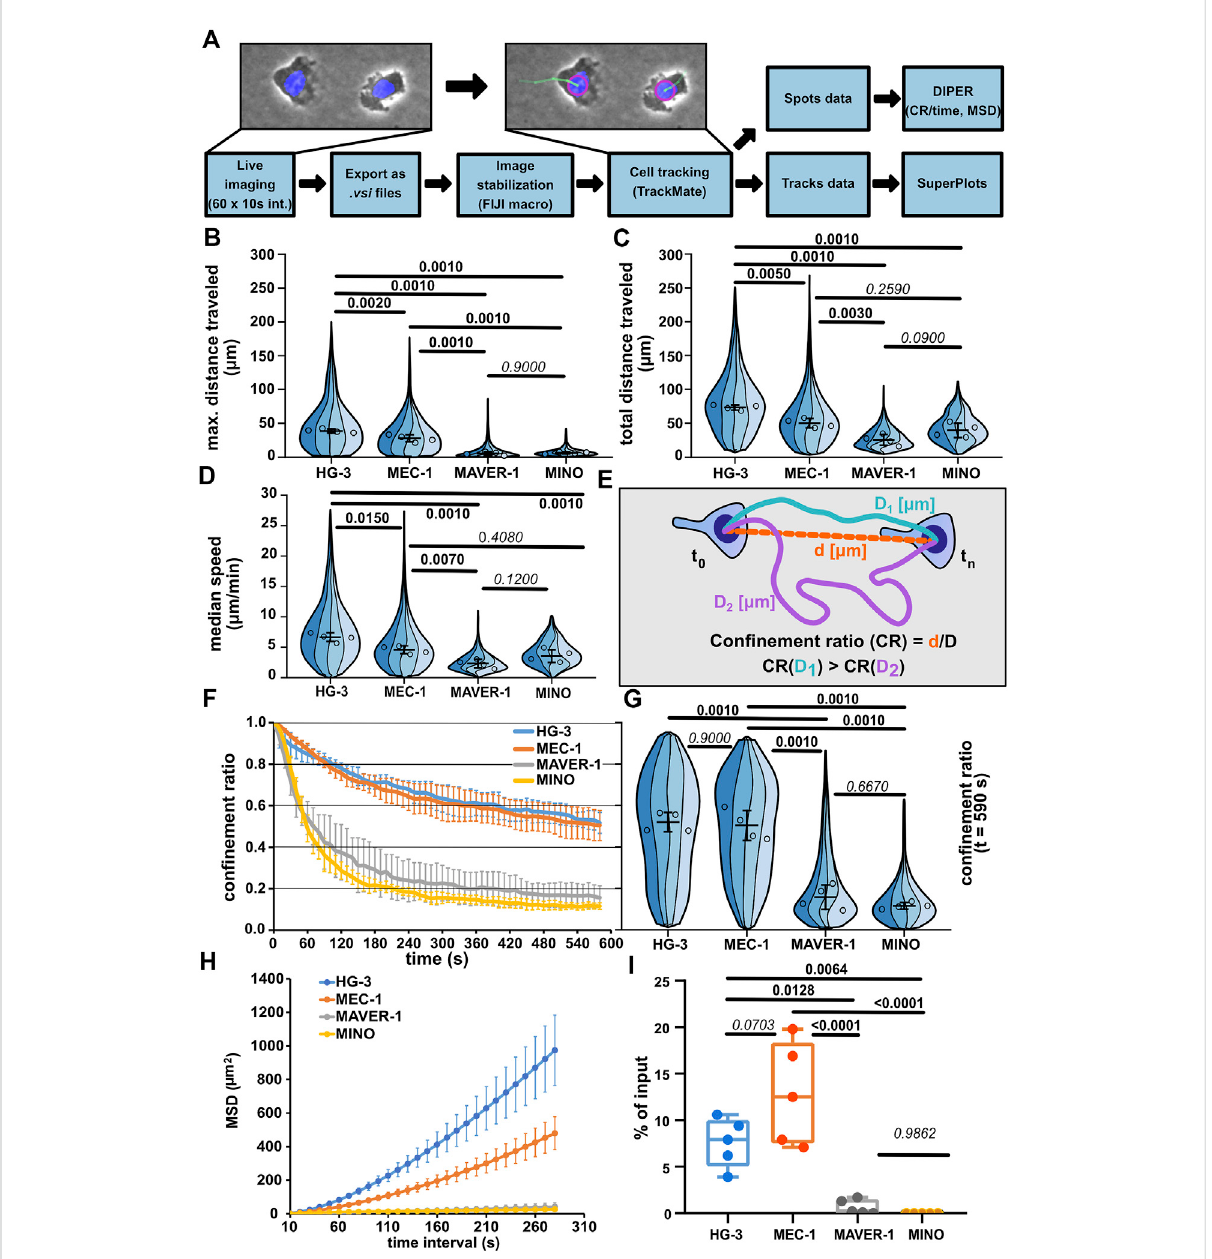
FIGURE 2 Comparison of migratory properties of leukemic cell lines. (A) Scheme of the data processing pipeline used for the quanti fi cation of migration parameters. FIJI macro used for pre-processing images for tracking can be found inSupplementary Materials. (B) Maximum distance traveled by the tested cell lines. SuperPlot sections of different colors represent distributions of individual replicates. Circles represent the median values of replicates,whichwereusedforstatisticalanalysis(one-wayANOVA, n =4, p < 0.001,andtheposthocTukeytest)( p valuesshowninthegraph). Errorbar:meanandSD. (C) Totaldistancetraveledbythetestedcelllines.SuperPlotssetasinFigure2B.Statistics:one-wayANOVA, n =4, p < 0.001, and the post hoc Tukey test. (D) Median speed of the tested cell lines. Superplot setting as in Figure 2B, statistics: one-way ANOVA, n = 4, p < 0.001, andtheposthocTukeytest. (E) Schematicdepictionofthecalculationofthecon fi nementratio(CR).D=lengthofthetrack(equalsto “ totaldistance traveled ” ) and d = cell displacement (direct distance from the fi rst to the last point in the given track). (F) Evolution of the CR of the tested cell lines over the period of tracking. The lines represent average value calculated from the replicate medians; error bar: SD. (G) Comparison of the CR of the tested cell lines atthe lastframe ofthetrackingperiod (t = 590 s). SuperPlot settings are as in Figure 2B.Statistics:one-wayANOVA, n = 4, p < 0.001, and the post hoc Tukey test. (H) Mean square displacement (MSD) analysis of the tested cell lines. MSD shows an increase in the area explored by migratorycellsoverdifferenttimeintervals.LinerepresentstheaveragevalueofreplicateMSDvaluescalculatedbyDIPER;errorbar:SD. (I) Transwell assay analysis of basal migration of the tested cell lines. Percentage of cells that migrated to the lower well of the chamber after 3 h incubation without chemokine gradient stimulation and normalized to the total number of cells pipetted to each well. Statistics: one-way ANOVA, n = 5, p < 0.001, and the post hoc Tukey test. The data presented in B, C, D, F, G, and H were derived from the same tracking experiments. Number of cells (tracks) used for quanti fi cation: HG-3 (76, 99, 193, 88), MEC-1 (149, 175, 387, 134), MAVER-1 (143, 95, 187, 87), and MINO (176, 99, 259,